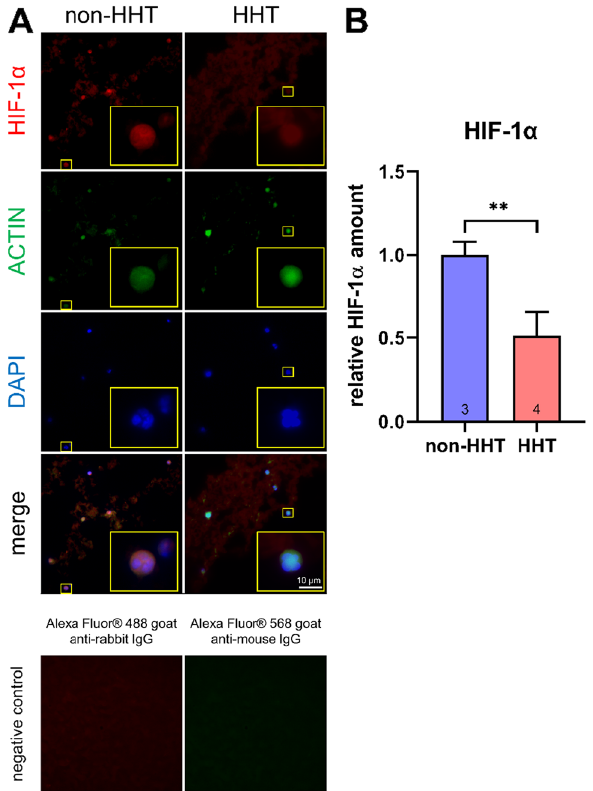
Figure 4. HIF-1α protein immunostaining in whole blood. Whole blood of HHT patients and non-HHT controls were immunostained. Examples of pictures from cells are shown in ( A ). HIF-1α is shown in red, ACTIN in green and the nuclei in blue. As negative control, staining with secondary antibody only is shown for non-HHT controls. Quantification of HIF-1α amount is shown in ( B ). HHT patients showed significantly less amounts of HIF-1α. Unpaired t-test was applied to determine significantly differences between the groups. Data are shown as mean ± SD, **p <